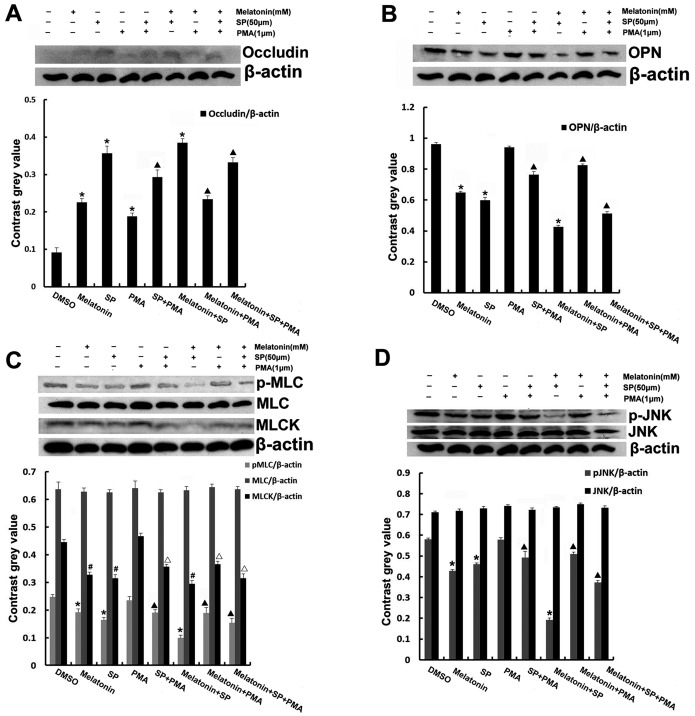
The Effect of melatonin, SP600125 and PMA on the expression of occludin, OPN, MLCK and phosphorylation of MLC, JNK.(A) occludin, (B) OPN, (C) MLC and MLCK, (D) JNK. Results are presented as mean ± SD of three independent experiments. *P<0.05, #P<0.05, in comparison to control; ▴P<0.05, △P<0.05, in comparison to PMA group.